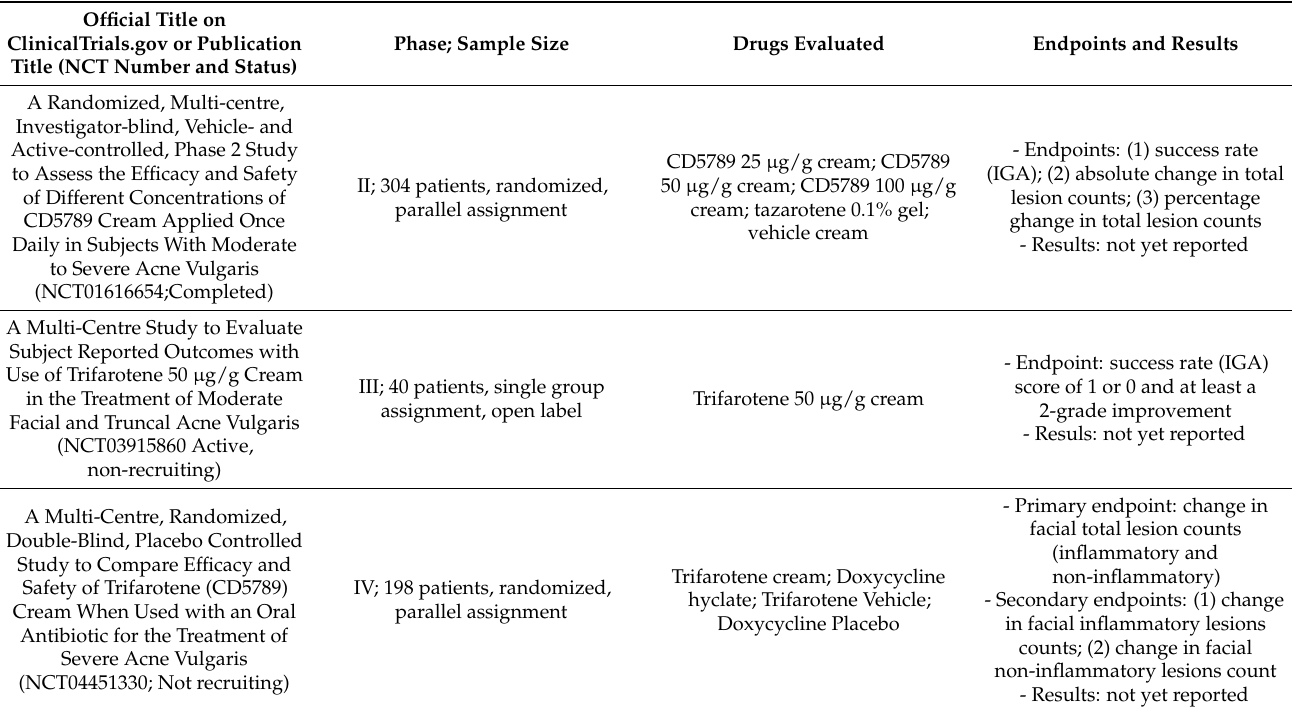
Table 3. Clinical trials evaluating trifarotene in acne vulgaris with no results reported yet. Abbreviations: IGA: Investigator’s global